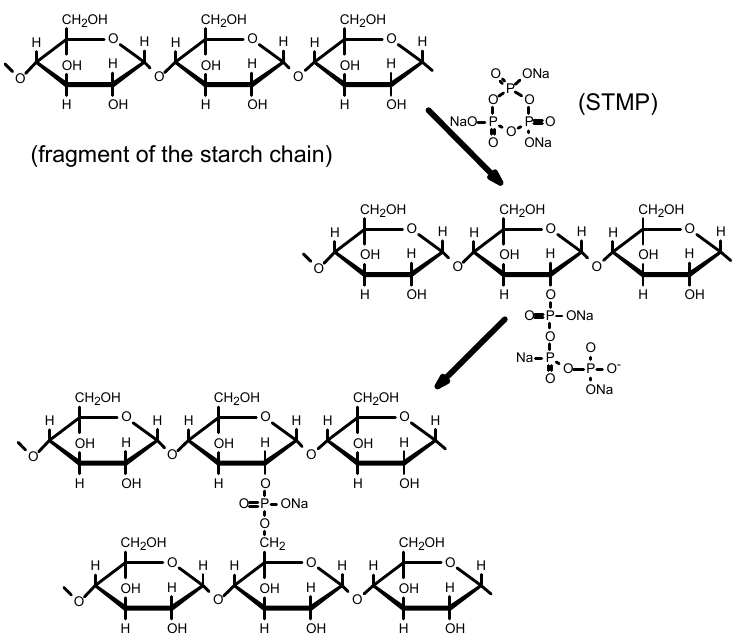
Figure 1. Mechanism of starch esterification caused by STMP in alkaline (pH = 10.5) suspension. During modification, cross-linking bonds may be formed between C2, C3, and C6 atoms [25].